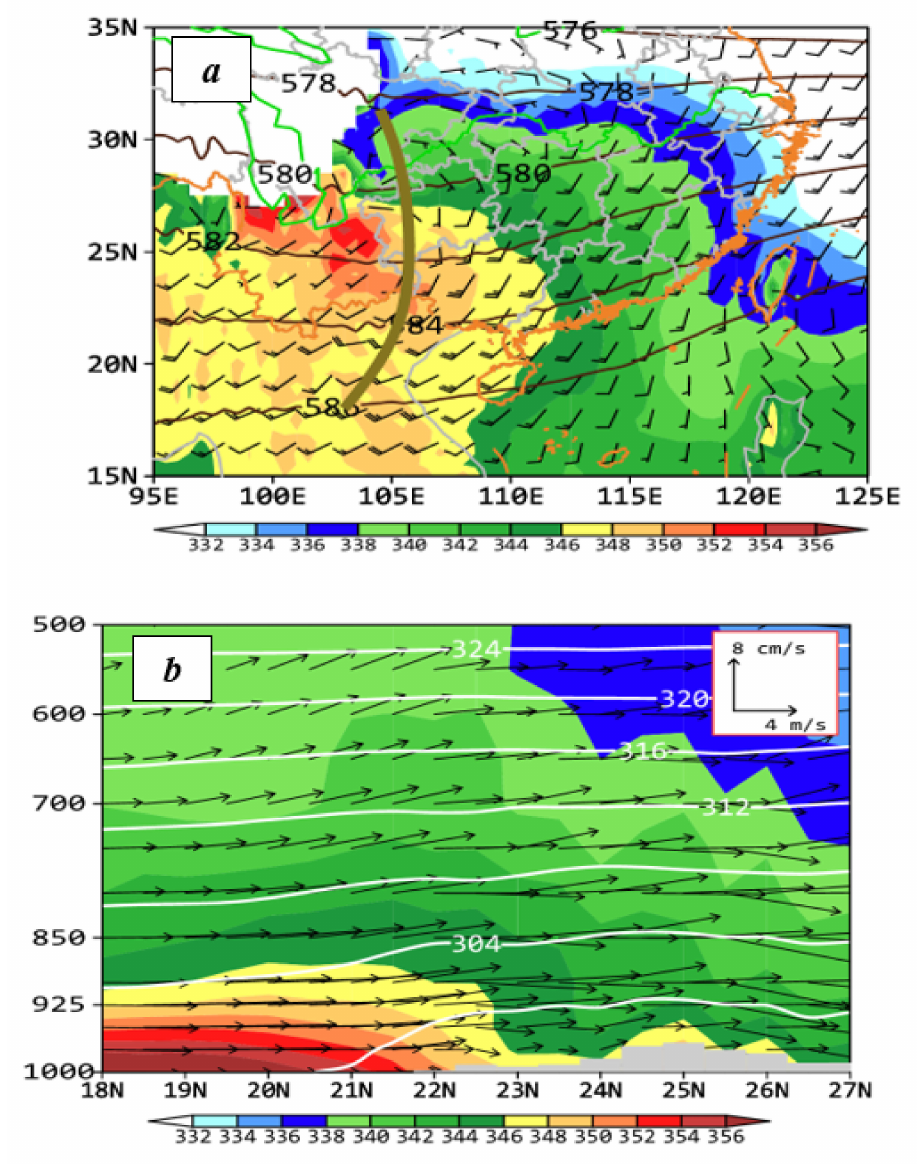
Figure 7. ( a , b ) As in Figure 5a,b, respectively, except for the 24 WMF-type WSHR events. A south–north vertical cross section through the Yangjiang station with the top HR amount reveals favorable isentropic uplifting of southwesterly flows below 850 hPa, in association with the above-mentioned quasi-geostrophic ascent, which is more pronounced across the coastline (Figure 7b). Unlike the PSF-type events that take place in an environ- ment with a deep-layer high- θ e air over a wide area in the warm sector, the horizontal extent and depth of high- θ e air associated with the WMF-type events are much limited